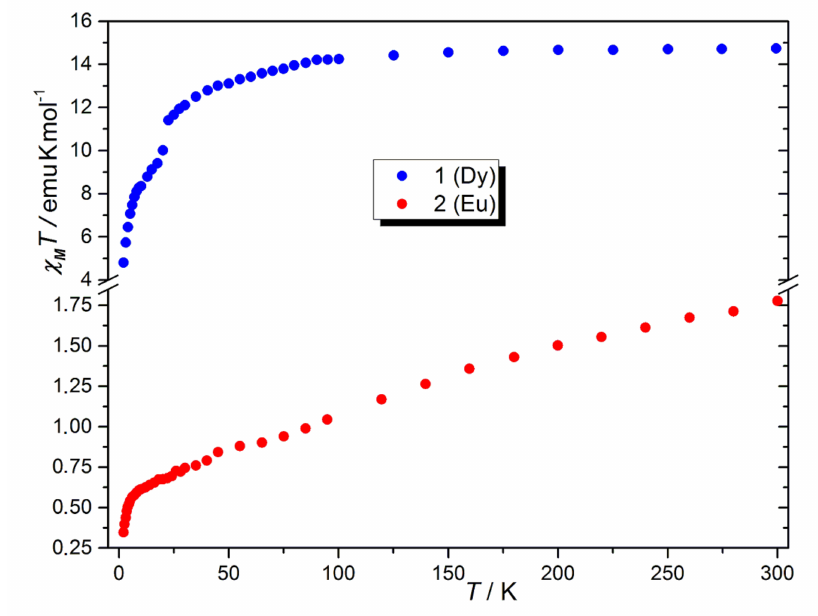
Figure 4. Temperature dependencies of χ M T products for 1 and 2